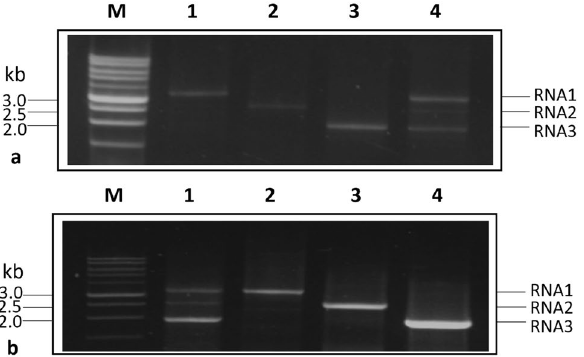
Figure 1. Amplification of whole genome of PNRSV by ( a ) one-step RT-PCR: Lane 1, 2 and 3 showing amplification of RNA 1, RNA 2 and RNA 3 respectively. Lane 4 is showing simultaneous amplification of RNA1, 2 and 3 by one-step mRT-PCR. ( b ) two-step RT-PCR: Lane 2, 3 and 4 showing amplification of RNA 1, RNA 2 and RNA 3 respectively. While Lane 1 shows simultaneous amplification of RNA 1, 2 and 3 by two-step mRT- PCR. Lane M showing 1 kb DNA ladder (RTU, GeneDireX,